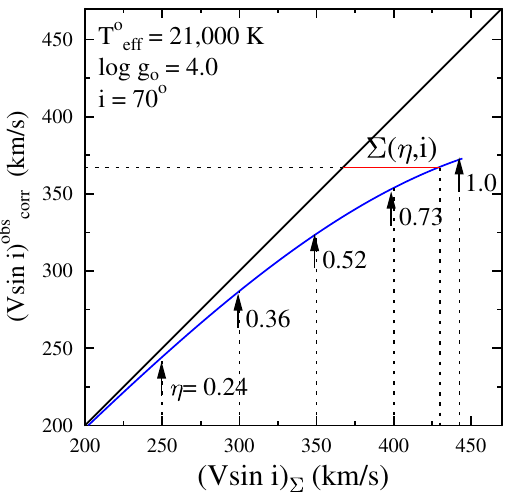
Figure 24. The blue line represents the relation between the observed ( V sin i ) obs corr corrected from observational uncertainties (ordinates) against the V sin i corrected from Stoeckley’s underestimation (abscissas). This relation was calculated with HeI 4471 line profiles for models with pnrc parameters T eff = 21,000 K and log g = 4.0, inclination angle i = 70 ◦ , and η ratios ranging from 0 to 1.0. The red bars indicate Stoeckley’s correction Σ for an arbitrary near critical ( V sin i ) obs corr parameter. The η values indicated in the figure are for the actual ( V sin i ) Σ = V ( η ) sin i parameters in abscissas. Adapted from Zorec et al.